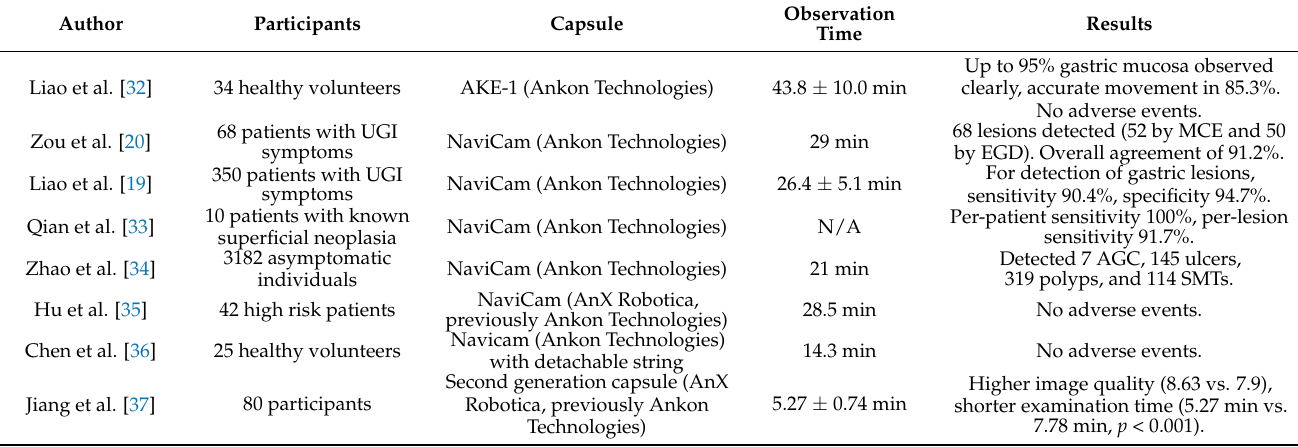
Table 4. Clinical studies using magnetic guided capsule gastroscopy controlled by robotic arm.